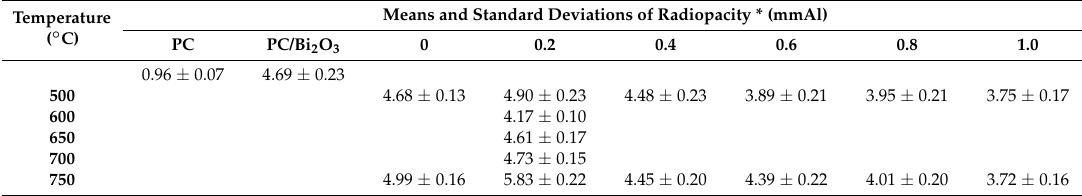
Table 1. Radiopacity properties of sol-gel Bi 2–x Zr x O 3+x/2